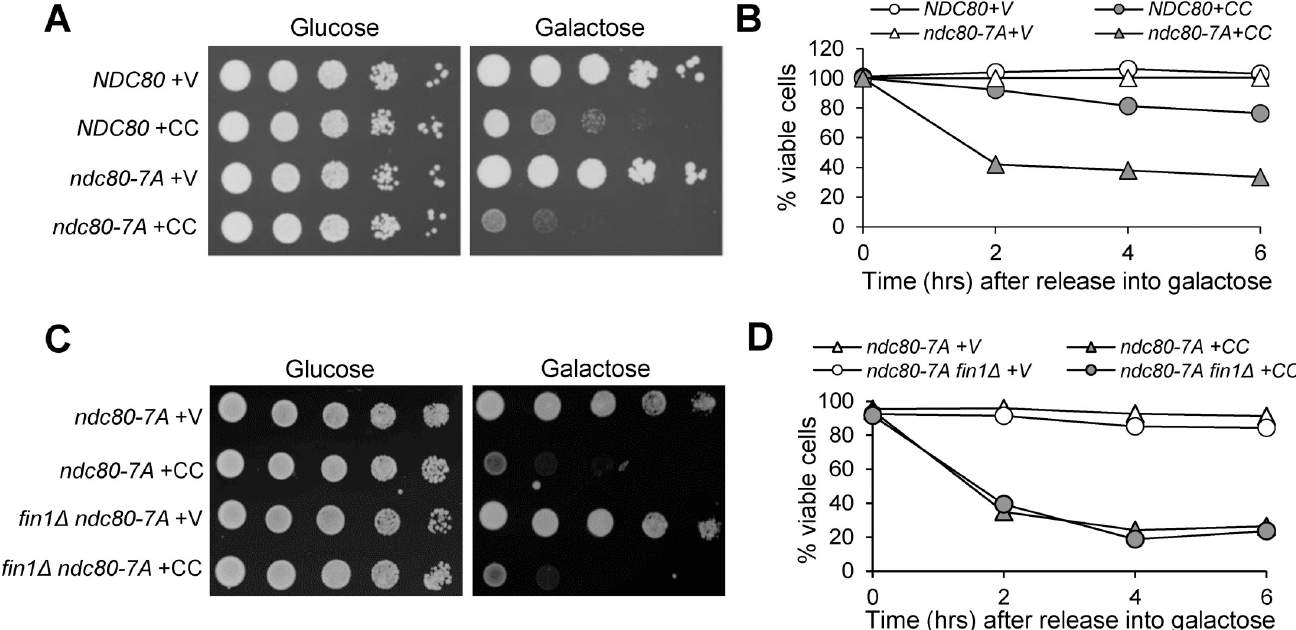
Fig 7. Phospho-deficient ndc80-7A mutant is sensitive to the induction of syntelic chromosome attachments. (A) ndc80-7A mutant cells are sensitive to CIK1-CC overexpression. NDC80 (SBY7258) and ndc80-7A (SBY7259) cells carrying vector (V, pRS416) or P GAL CIK1-CC (CC, pYW200) plasmid were grown to saturation, 10-fold serially diluted and plated onto glucose and galactose plates. The plates were incubated at 30˚C for 2 days before scanning. (B) The same strains were grown to log-phase in raffinose media, then galactose was added to a final concentration of 2%. The cells were collected every 2 hours and spread onto YPD plates. Plates were grown at 30˚C overnight for plating efficiency (n � 300). (C) fin1 Δ mutant does not suppress the sensitivity of ndc80-7A cells to CIK1-CC overexpression. ndc80-7A (3932-5-1) and fin1 Δ ndc80-7A (3932-3-1) cells carrying vector (V, pRS416) or P (CC, pYW200) plasmid were grown to GAL CIK1-CC saturation, 10-fold serially diluted and plated onto glucose and galactose plates. Plates were grown at 30˚C for 2 days before scanning. (D) The same strains were used to determine the viability as described above (n �